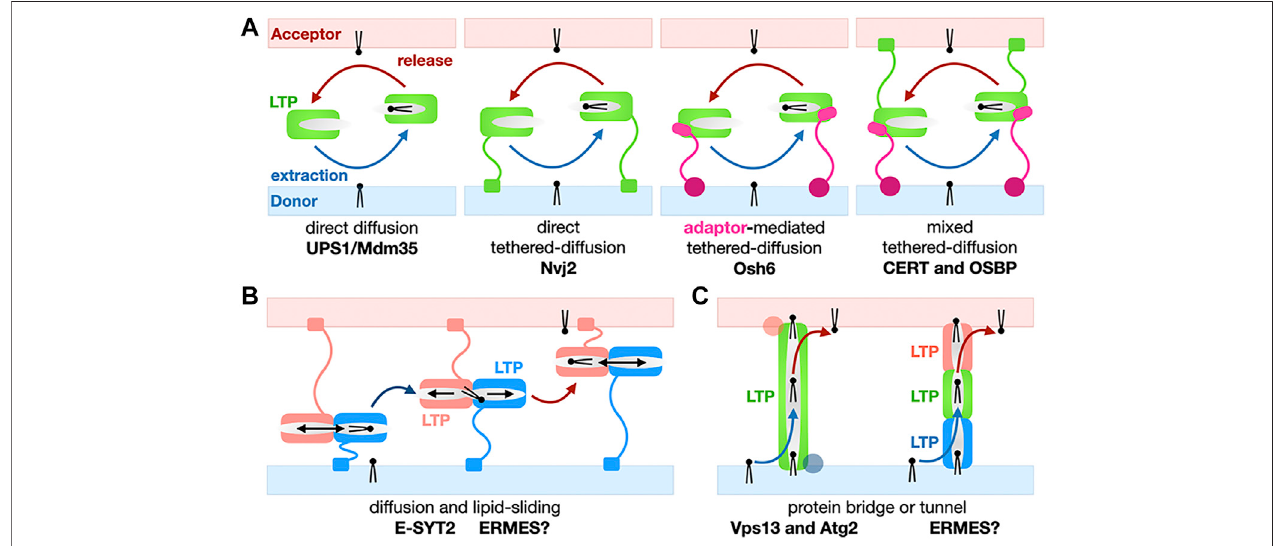
FIGURE 4 | Basic mechanisms for the non-vesicular exchange of lipids using lipid transfer proteins. (A) Transfer based on protein domain diffusion. Variations on theuseofasolubleLTPdomainfortheshuttlingoflipidsbetweenmembranes:Soluble versus tetheredLTPshuttleswithorwithoutcombinationofproteinmotifsand/or adaptor proteins targeting the LTP module to a speci fi c MCS. Membrane-tethering motifs on the LTP or the adaptor can be present on both membranes. Only monovalenttethers/adaptorsareshownhereforthesakeofsimpli fi cationbutmorecomplexexampleshavebeendescribed. (B) Transferusinglipidslidingwithina LTP domain combined with diffusion. Here we show a general simpli fi ed model; E-SYT2 (and possibly ERMES?) fall under this general category. (C) Transfer based on lipid bridges/tunnels. The lipid conduit spans the entire space separating the two organelles at a MCS can consist of one large LTP/tether protein (Vps13 and Atg2) or several LTPs (possibly SMP domains in